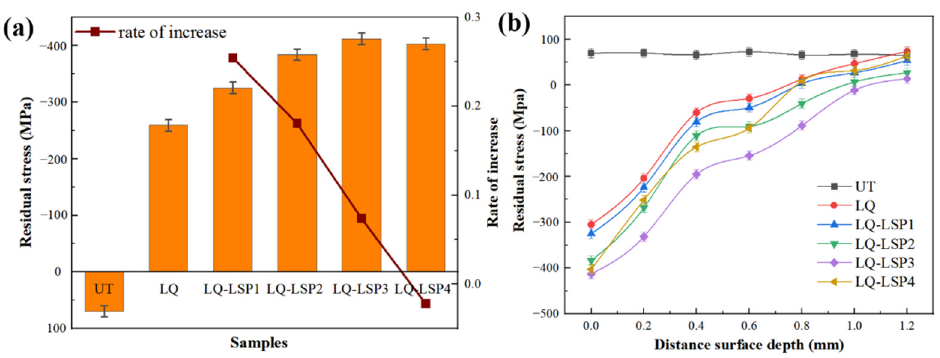
Figure 9. The surface residual stress and section residual stress distribution of samples treated by different processes—( a ) surface residual stress; ( b ) section residual stress .